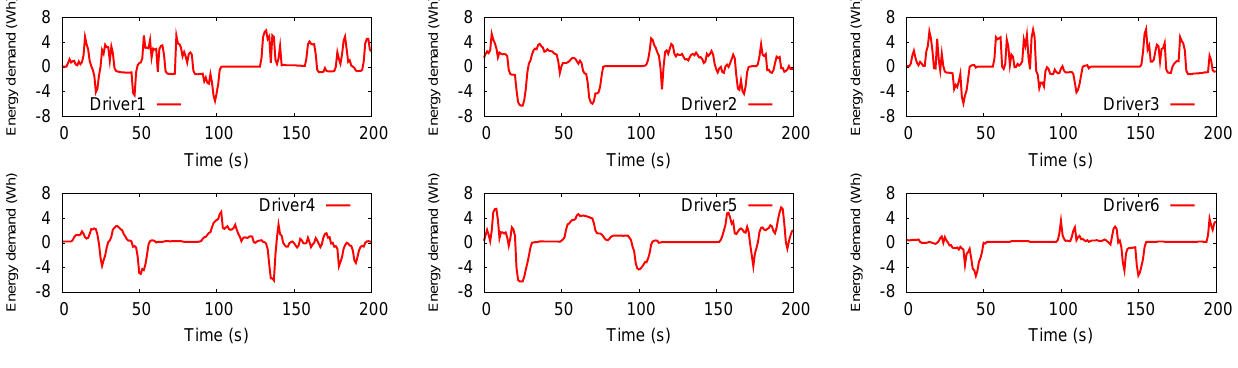
Figure 14. Real-time energy demand of different drivers.